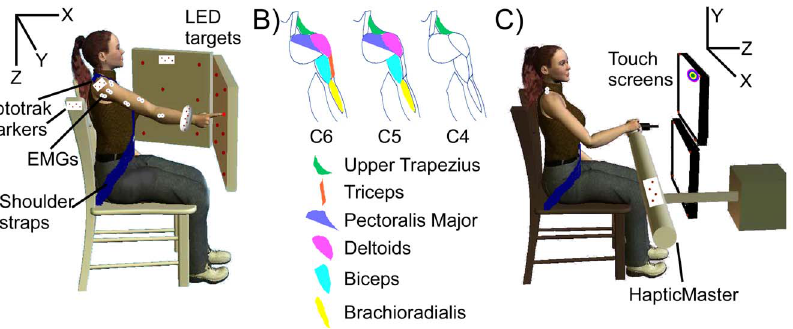
Figure 1. Experimental setups A) Natural reaching data; B) Muscles recorded to simulate levels of SCI; C) Closed-loop experiment.